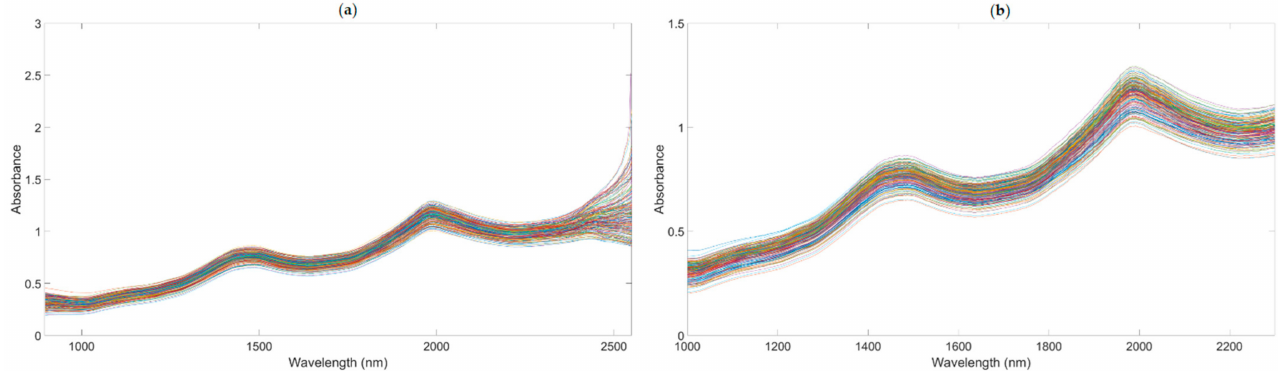
Figure 4. The NIR diffuse reflection spectral of the snow pears. (The lines in figures are the absorbance values of 195 samples at the different wavelengths.). ( a ) NIR raw spectra. ( b ) NIR raw with the range of 1000–2300